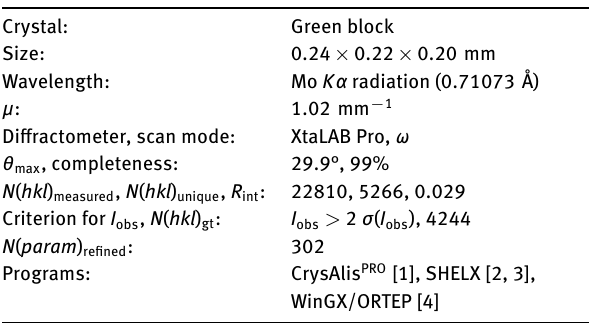
Table 2: Fractional atomic coordinates and isotropic or